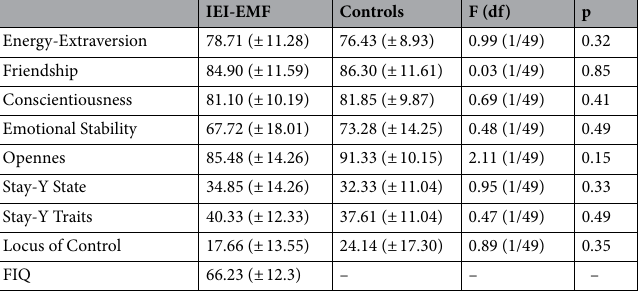
Fig. S1. Each 1 H-NMR spectrum can be divided into two main spectral zones: the region between 0.5–5.5 ppm characterized by a large number of partly overlapping peaks due to the aliphatic groups of free amino acids, organic acids and sugars, and the region between 6.8–8.5 ppm characterized by the signals from the aromatic metabolites. The whole 1 H-NMR dataset was subjected to multivariate statistical analysis. PCA analysis (data not shown) was performed to evaluate the homogeneity of the samples in each group (IEI-EMF and controls) and identify potential outliers (outside the 95% confidence limit). Both IEI-EMF and control groups resulted in